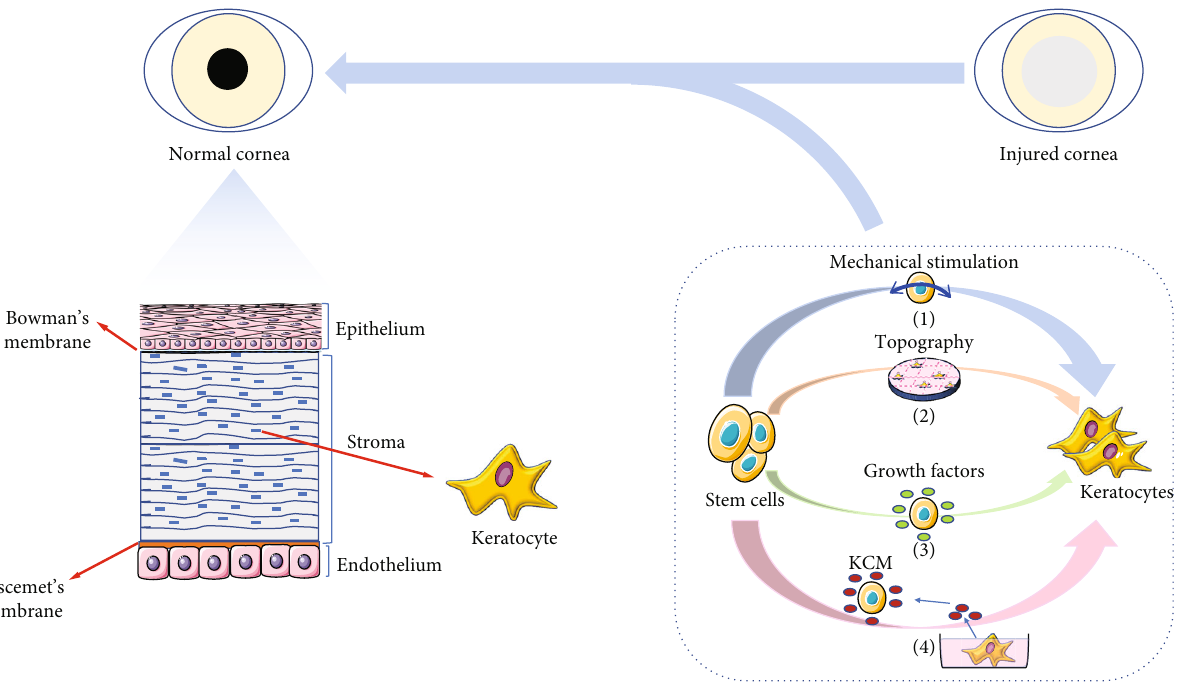
Figure 3: Schematic diagram summarizing the whole scope of the article. The normal cornea consists of fi ve layers — the epithelium layer, Bowman ’ s membrane, the stroma layer, Descemet ’ s membrane, and the endothelium layer. We summarized the tissue engineering strategies that can make it possible to restore the damaged cornea to a normal